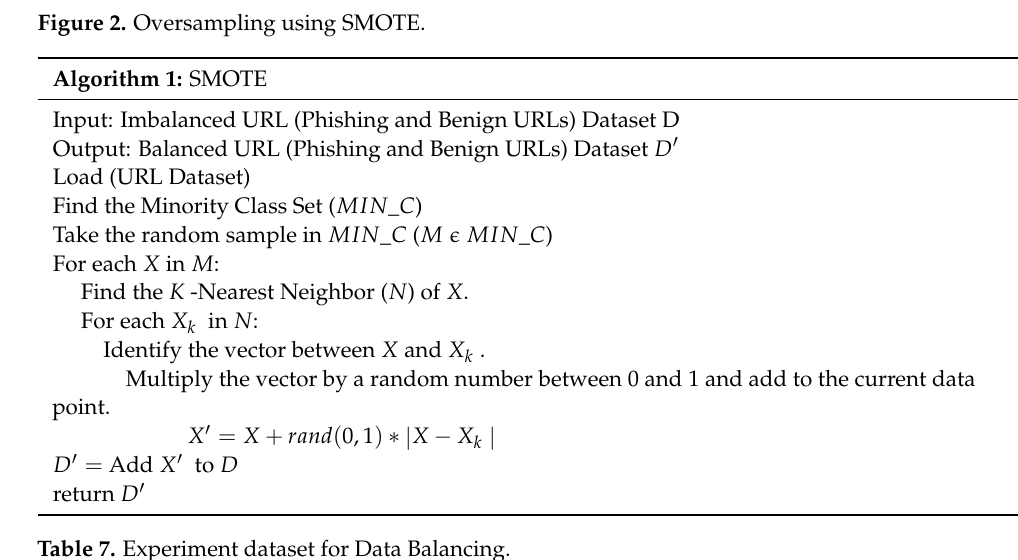
Table 7. Experiment dataset for Data Balancing.